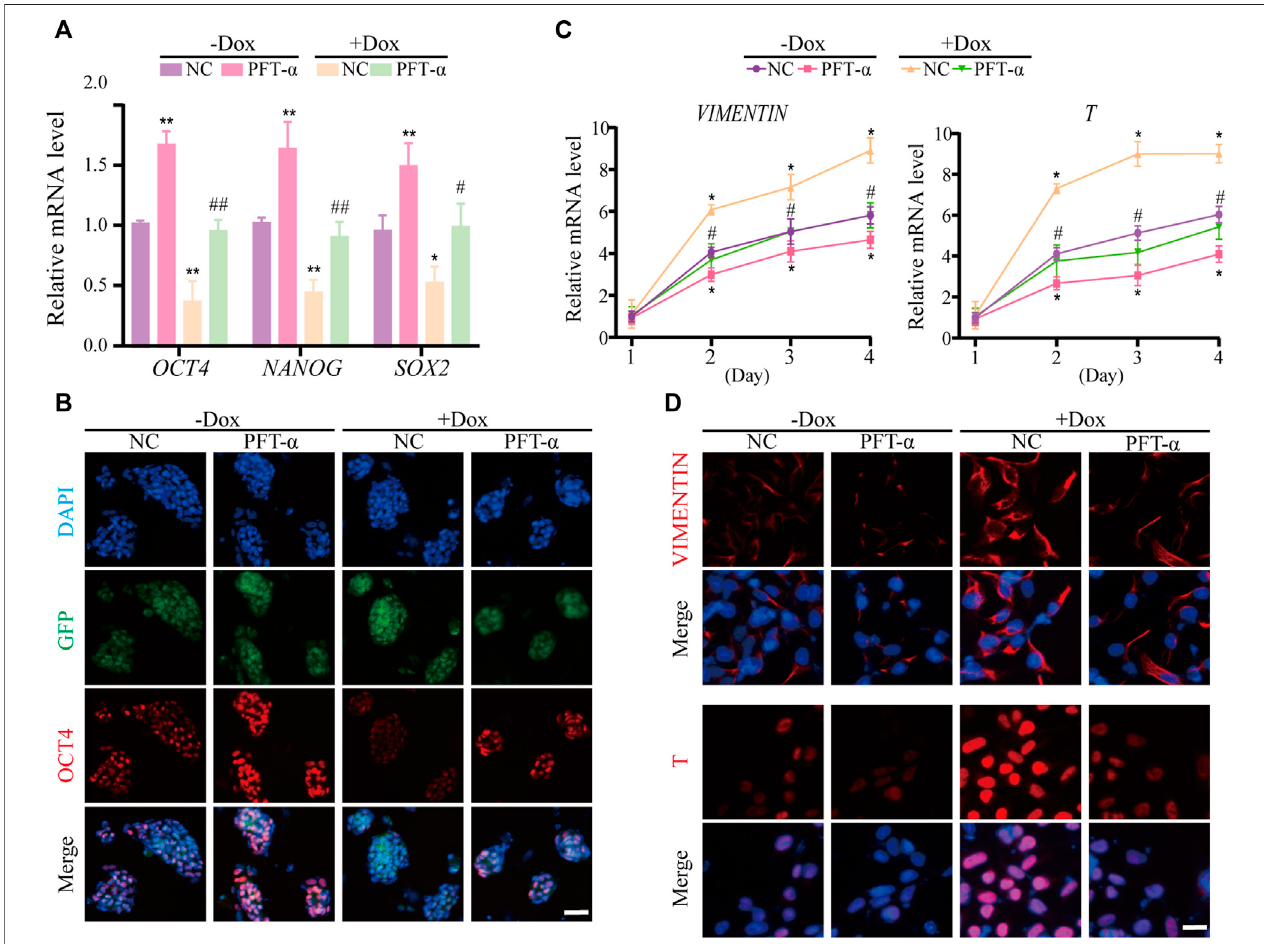
FIGURE6| InhibitionofP53couldrestorethein fl uencesofWDR36 knockdown onhEPS1cells. (A) qRT-PCRanalysisoftheDox-induced shWDR36hEPS1cells cultured under the condition with or without Dox. (B) Immuno fl uorescent images of OCT4 in Dox-induced shWDR36 hEPS1 cells. (C) Expression of T and vimentin in Dox-induced shWDR36 hEPS1 cells. (D) Immuno fl uorescent images of T and vimentin in Dox-induced shWDR36 hEPS1 cells. Bars = 50 μ m. NC, culture condition did not contain 10 μ M PFT- α . n = 3 experiments; mean ±S. D; one-way analysis ofvariance (ANOVA). *, 0.01 < p < 0.05; **, p < 0.01; #, 0.01 < p < 0.05; ##, p < 0.01; no labeling indicates no statistical signi fi